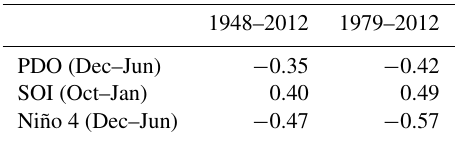
Table 3. Correlation coefficient of the Elbrus Ca 2 + data and large- scale atmospheric circulation